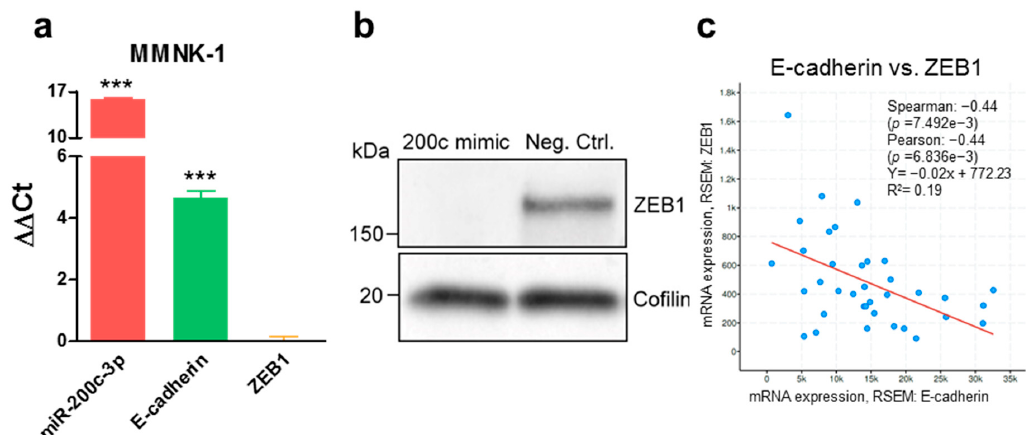
Figure 2. Transient miR-200c-3p overexpression induces an epithelial phenotype through the interaction with E-cadherin and ZEB1. ( a ) MMNK-1 cells were transiently transfected with 10 nM mirVana miR-200c-3p mimic, and the expression levels of miR-200c-3p, E-cadherin ( CDH1 ), and ZEB1 were compared to those of respective cells transfected with 10 nM mirVana mimic negative control. Positive values represent an overexpression. A value of 0 indicates that there was no difference between cells transfected with miR-200c-3p mimic and mimic negative control. Unpaired two-tailed t-test was used to evaluate statistical significance. *** p < 0.001. ( b ) ZEB1 protein levels were compared between miR-200c-3p mimic-transfected MMNK-1 cells and Neg. Ctrl.-transfected MMNK-1 cells. Cofilin was used as loading control. ( c ) In silico correlation analysis of E-cadherin ( CDH1 ) and ZEB1 expression levels in 36 human BTC tissue samples from The Cancer Genome Atlas.